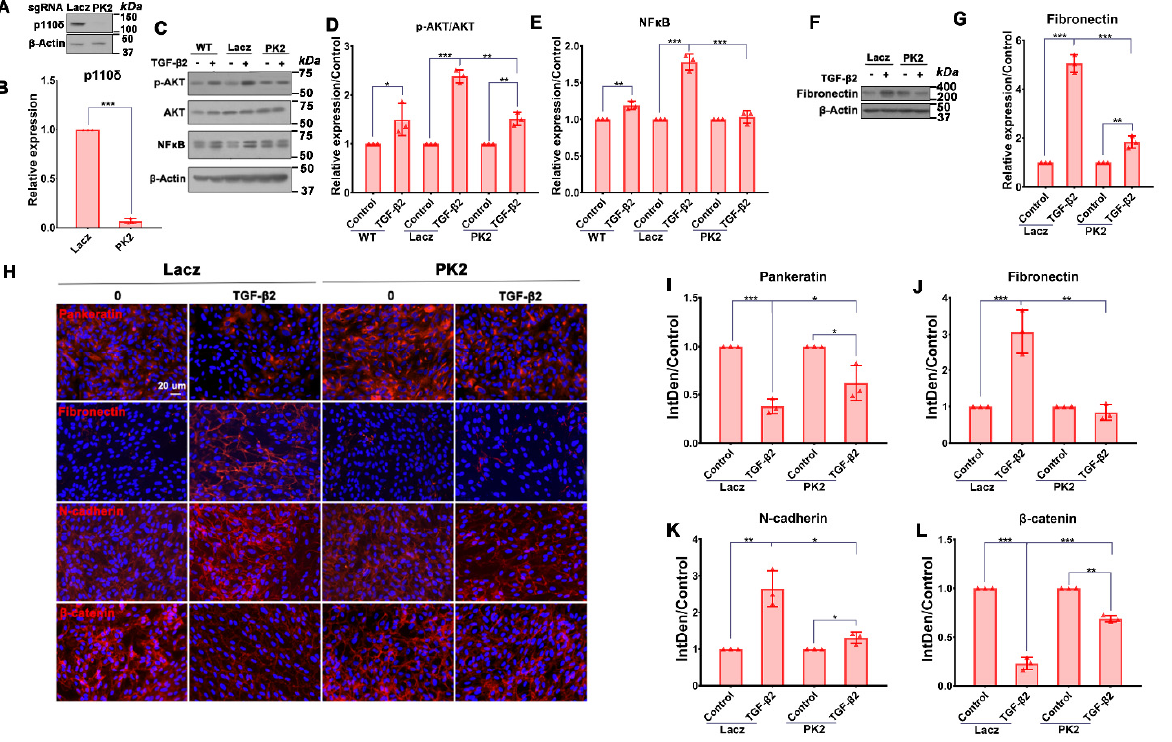
Figure 4. Depletion of NF κ B/p65 attenuates TGF- β 2-induced Akt activation, p110 δ expression and EMT. ( A , B ). ARPE-19 cells with lacZ-sgRNA/SpCas9 or PK2-sgRNA/SpCas9 were examined by Western blotting using indicated antibodies. Shown is a representative of at least 3 independent experiments ( A ); Quantitation of Western blotting band intensity in A ( B ). ( C – G ). Serum-starved ARPE-19 expressing SpCas9 with LacZ or PK2 sgRNA were treated with TGF- β 2 (10 ng/mL) for 48 h. Their lysates were subjected to Western blot analyses using indicated antibodies. Shown is representative of at least 3 independent experiments ( C , F ). Quantitation of Western blotting band intensity in ( C – G ). ( H ). ARPE-19 cells expressing SpCas9 with LacZ or PK2 sgRNA treated with TGF- β 2 (10 ng/mL) for 48 h were first stained with antibodies against fibronectin (rabbit), pan-keratin (mouse), N-cadherin (rabbit) and β -catenin (rabbit), followed by incubation with fluorescently labeled secondary antibodies and mounting of the slides in mounting medium containing DAPI (blue). Red signals indicate proteins expression. Shown is a representative of 3 independent experiments. Scale bar: 20 µ m. ( I – L ). Integrated density of the fluorescence was analyzed by Image J. The bar graphs are mean ± SD of 3 independent experiments. * p < 0.05, ** p < 0.01, *** p <